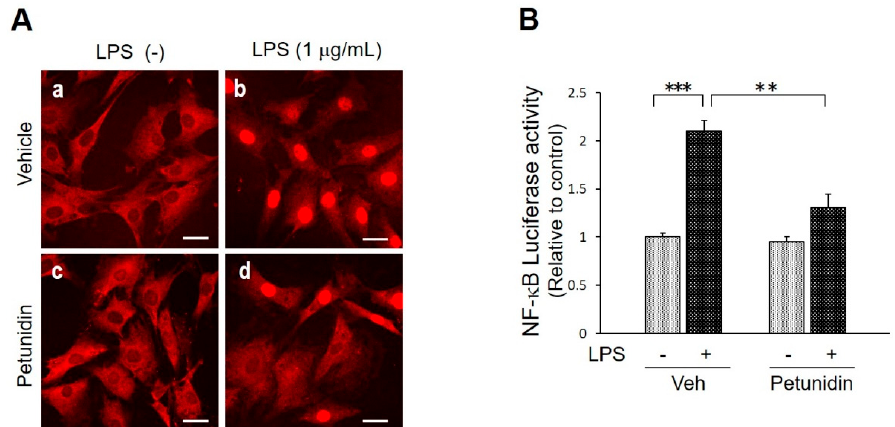
Figure 6. Effects of petunidin on NF- κ B nuclear translocation. ( A ) Immunofluorescent staining of MC-3T3 cells for NF- κ B p65. Cells were grown for 3 days with or without 32 μ g/mL petunidin, then stimulated with 1 μ g/mL lipopolysaccharide (LPS) for 1 h. Scale bars = 30 μ m. ( B ) MC3T3-E1 cells